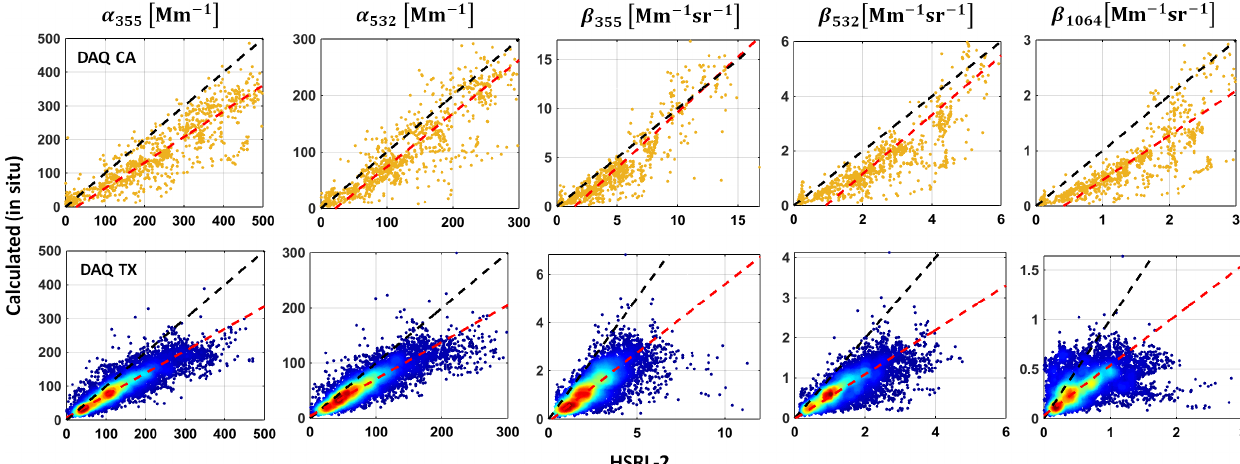
Figure 8. Comparison between calculated and measured 3 β + 2 α . The measurements obtained with the HSRL-2 are on the x axis and the optical parameters calculated from the adjusted in situ size distributions measured with the UHSAS (see text). The black dashed lines represent the 1:1 line and the red dashed lines correspond to bisector linear regression fit of each data set (see Table 1 for fit parameters). DAQ TX data are presented as scatter density